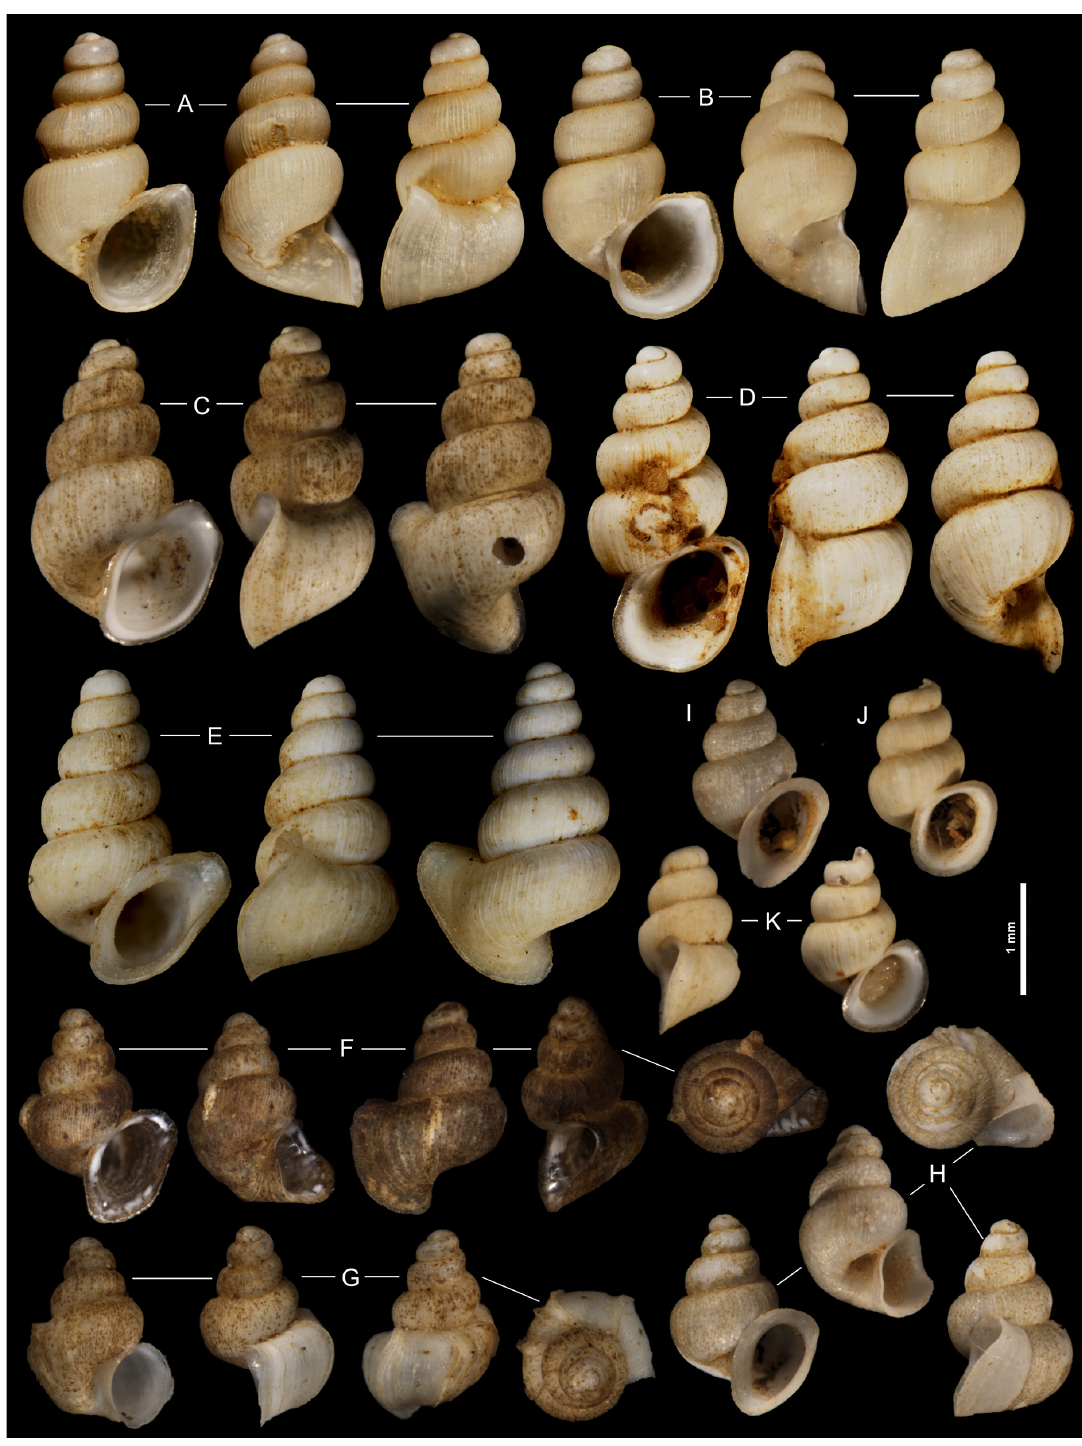
Fig. 12. A – B . Plagigeyeria jakabi sp. nov., Studenci, spring Guljevina A . Holotype (HNHM- MOLL-104172). B . Paratype (JG F1204). C – D . P. vriosticaensis sp. nov., Vitina, Vrelo Vrioštica C . Holotype (HNHM-MOLL-104182). D . Paratype (JG F1214). E . P. angyaldorkae sp. nov., Vrelo Jakšenica (holotype HNHM-MOLL- 104163). F . P. ozimeci sp. nov., Vitina, Vrelo Vrioštica, holotype (HNHM-MOLL-104173). G – K . P. ozimeci sp. nov., Vitina, Vrelo Vrioštica, paratypes (JG